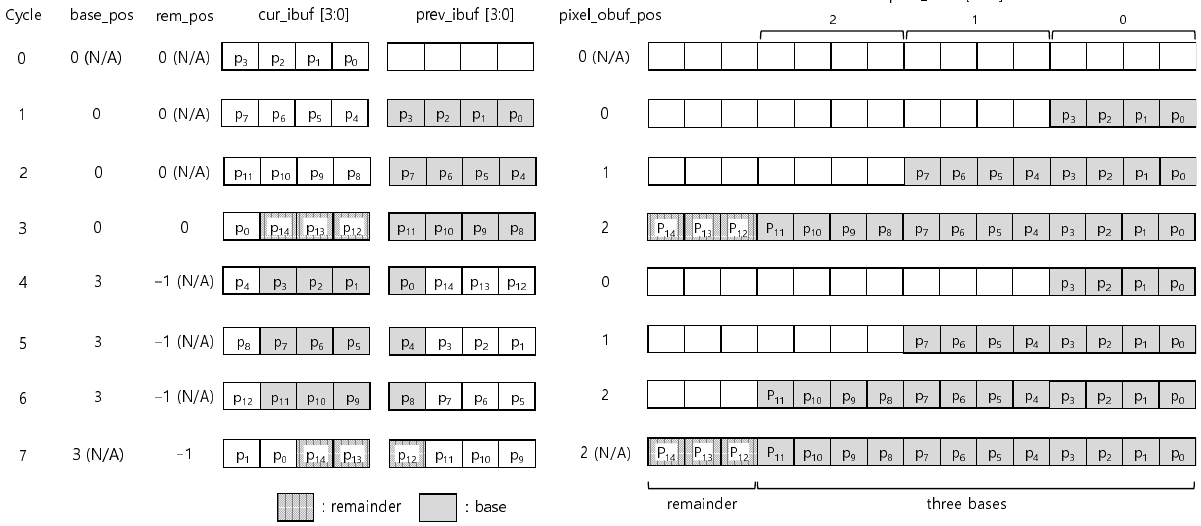
Figure 8. An example with 9-byte pixel data ( n = 3, α =